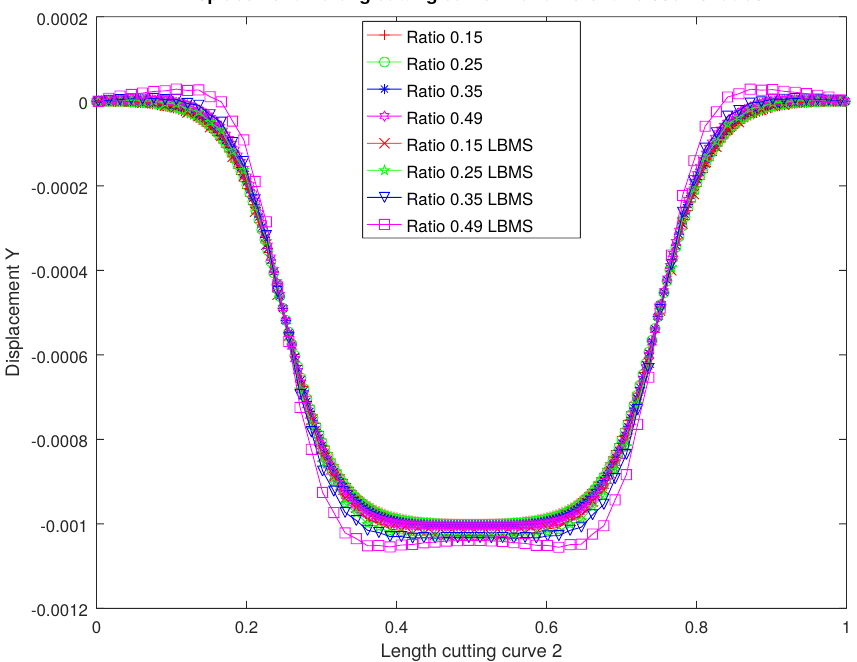
Figure A12. Second displacement components along cutting curve C 2 for positive Poisson’s